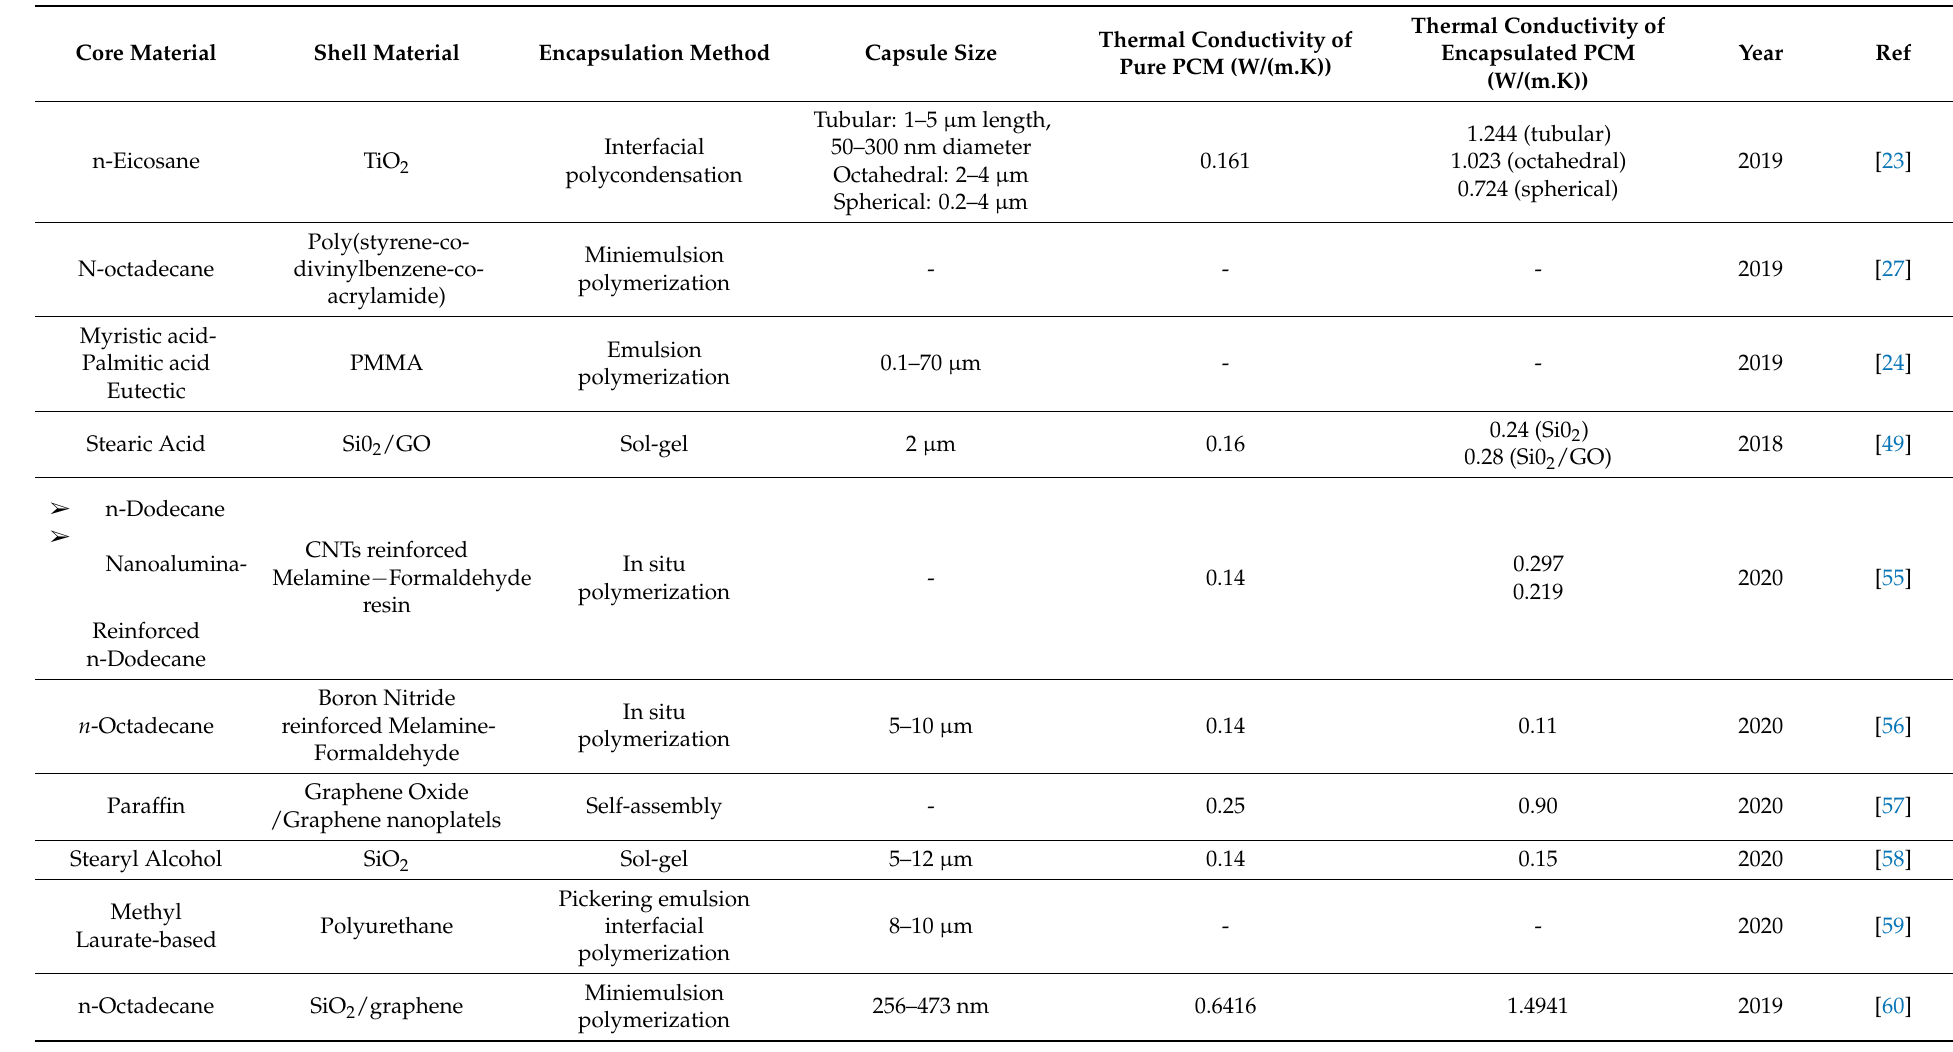
Table 5. Recent applications of micro- and nanoencapsulated PCMs with improved thermal